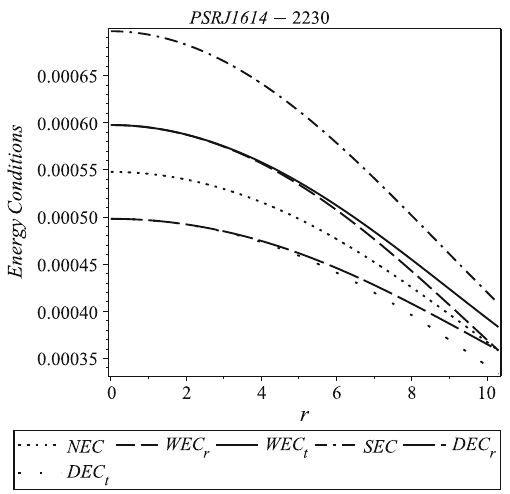
Fig. 4 Variationofthedifferentenergyconditionsw.r.t.theradialcoor- dinate r for the strange star candidate PSRJ